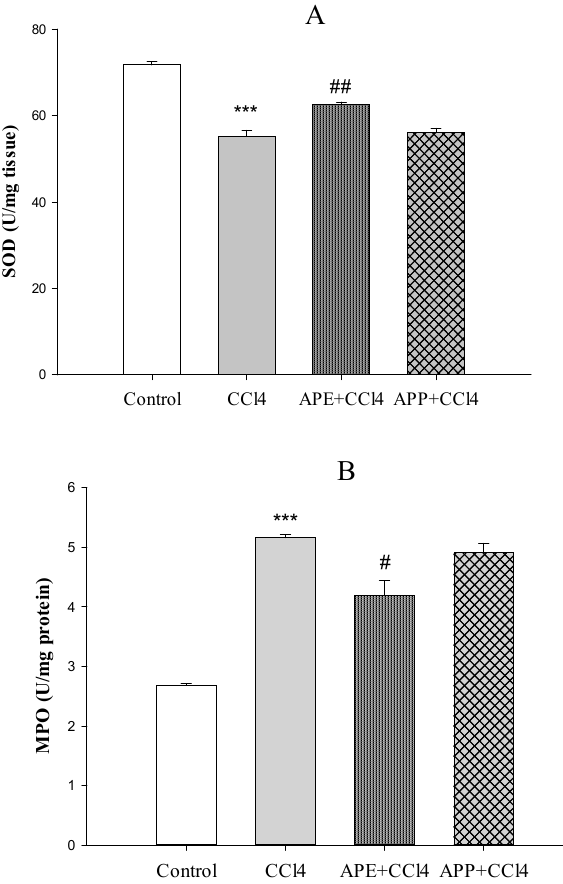
Figure 3. The effects of APE (30 mg/kg, oral), APP (30 mg/kg, oral), and CCl 4 (2 mL/kg; ip (intraperitoneal administration) once on third day) administration on the SOD ( A ) and MPO ( B ) levels in liver tissue in rats. Data are expressed as mean ± SD. *** p < 0.001 compared to the control group, # p < 0.05, ## p < 0.01 compared to the CCl 4 group.